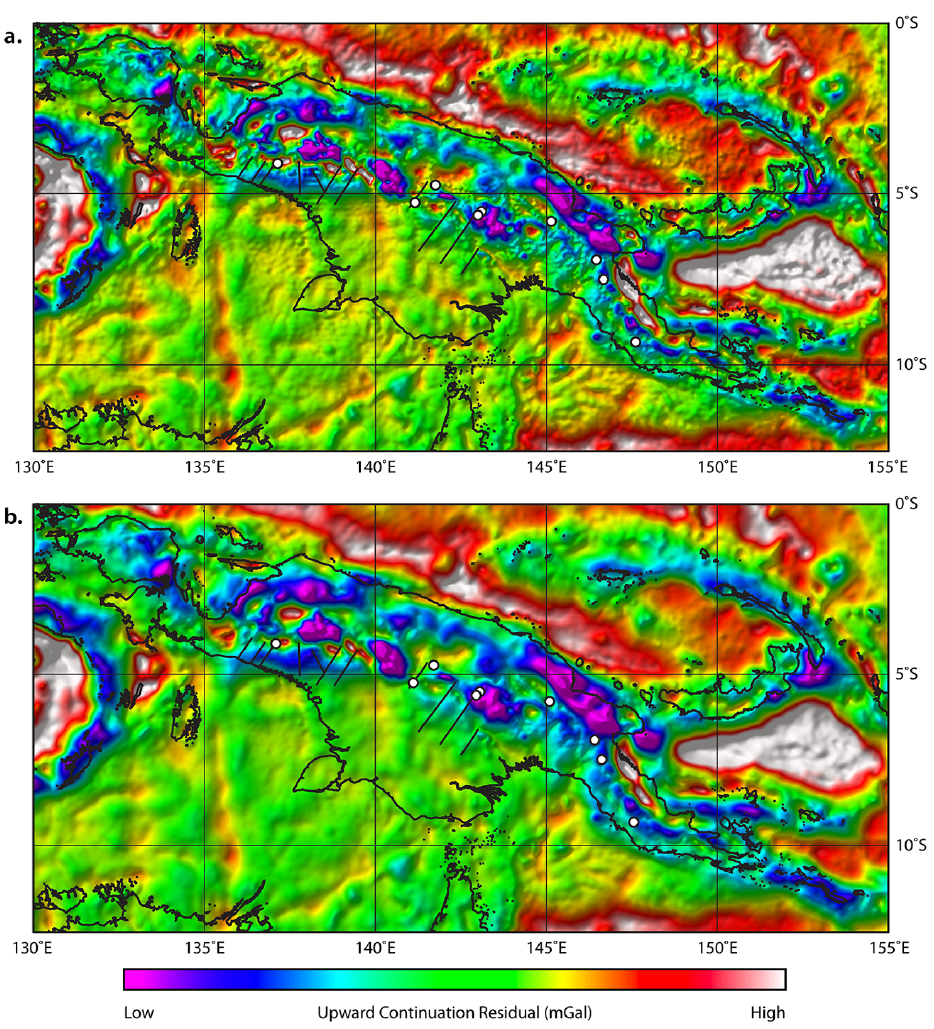
Fig. 7. Upwards continuation residual (UCR) filter applied to the BGI Bouguer gravity data. The Bouguer gravity data were calculated as if they were collected by a measurement at 5, 10, 40 and 50kma.s.l., and new grids were produced by (a) subtracting the 40km grid from the 5km grid, and (b) subtracting the 50km grid from the 10km grid. The illumination direction that was used in (a) and (b) is from the southeast. This was used to highlight any NNE-trending structures. The same grids were generated with different illumination angles to interpret lineaments with other orientations. The location of major Au/Cu/Ag/Mo deposits is shown as white circles (See Fig. 1a for more details). The NNE-trending lineaments that were proposed by Hill (1991) and Kendrick et al. (1995) are shown as thin black